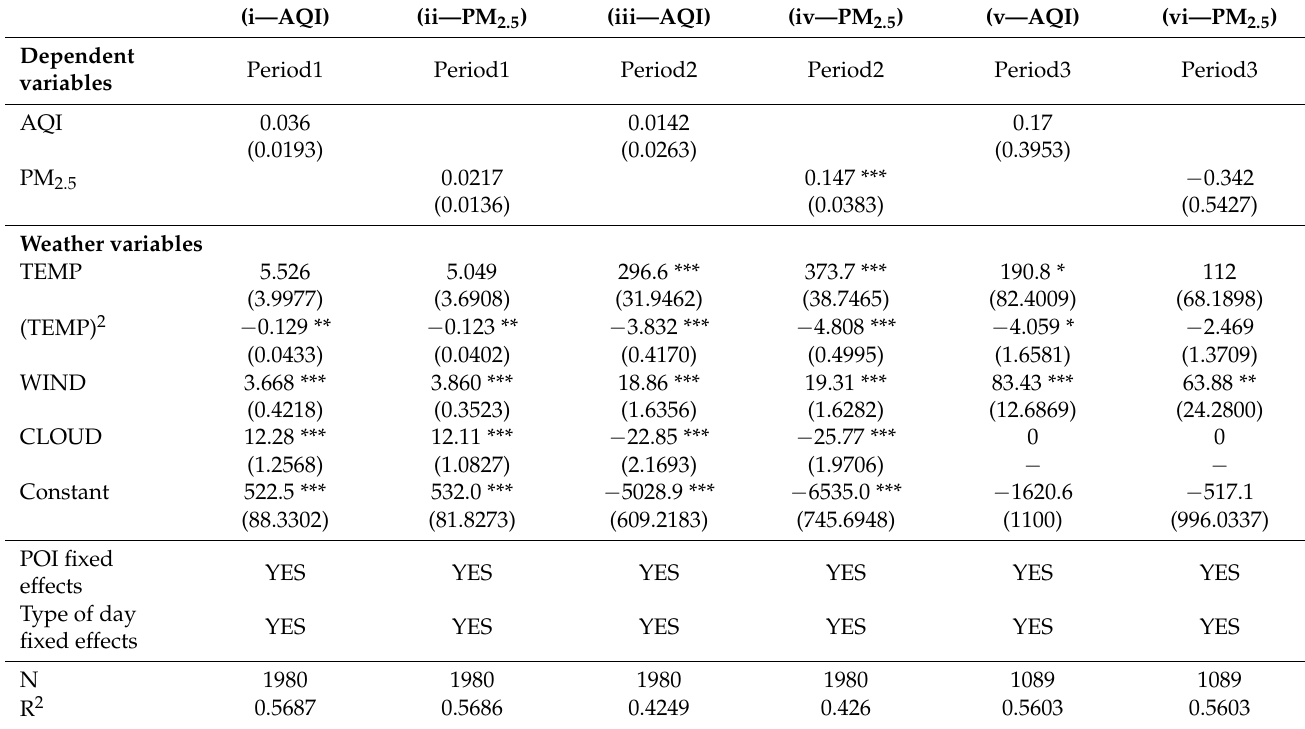
Table A15. Estimations of effects of air pollution on people’s activity of transportation mode options on bus stop